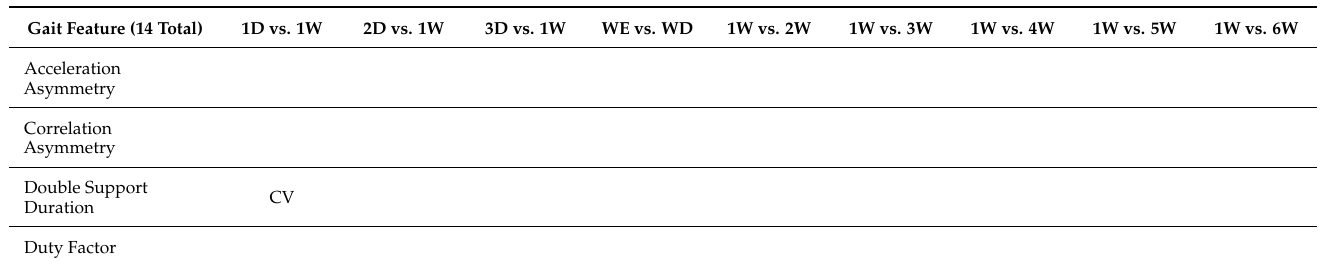
Table A1. Gait feature rank sum difference testing in persons with